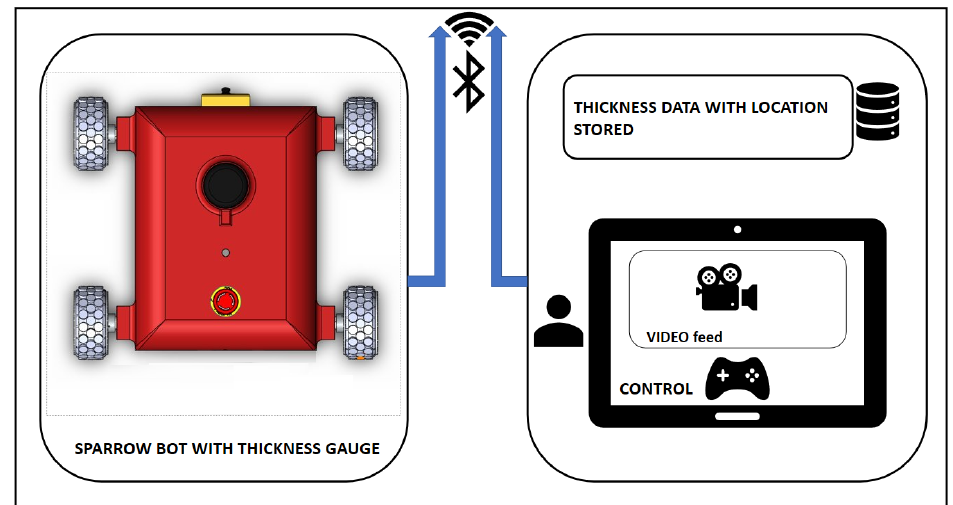
Figure 4. Overview of the proposed system.